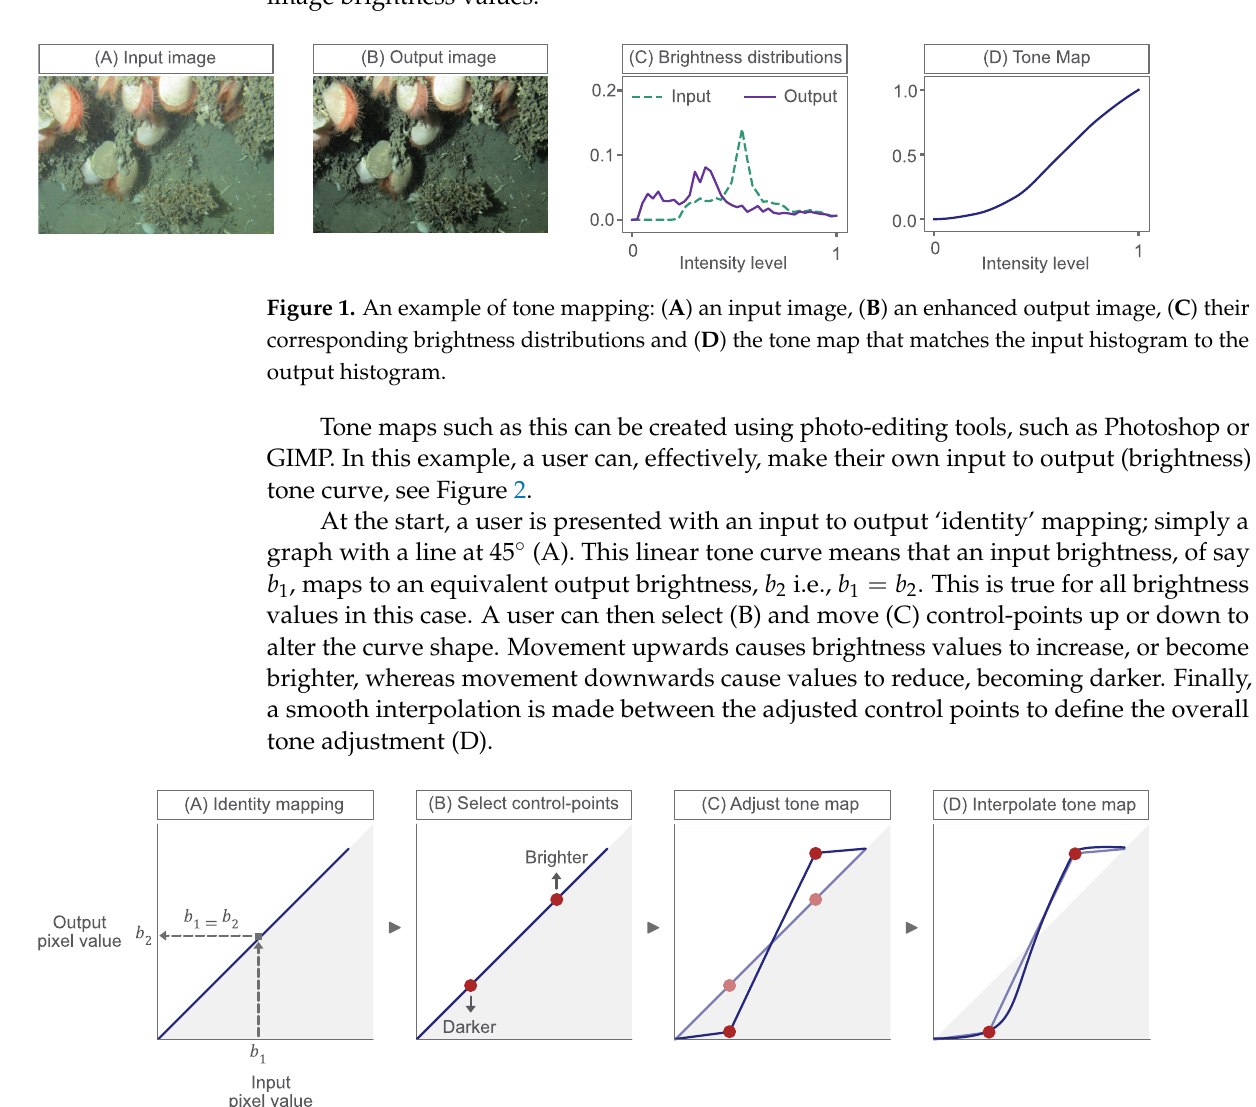
Figure 1. It uses a tone curve, or transform curve, which simply defines how to change image brightness values.